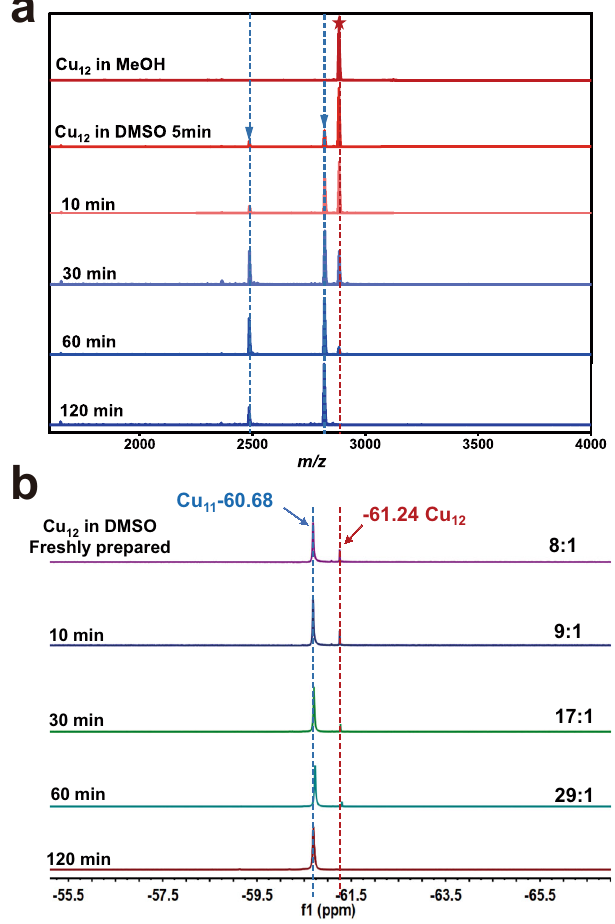
Fig. 5 Conversion of Cu 12 to Cu 11 . a Changes in the ESI-MS spectrum of Cu 12 in DMSO. b Changes in the 19 F NMR spectrum of Cu 12 in DMSO- d 6